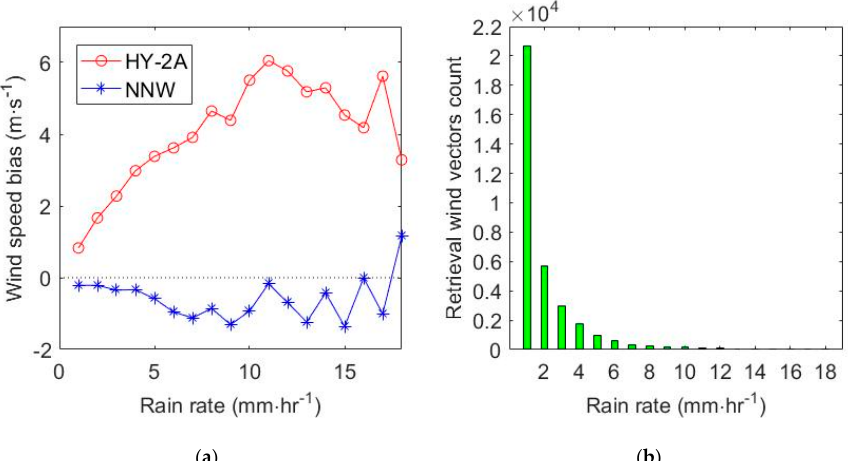
Figure 9. Dependence of wind speed residual and number statistics on the SSM / I rain rate. ( a ) The result of error verification, the dashed line in the figure represents σ 0 bias is 0; ( b ) The number of matched data samples.